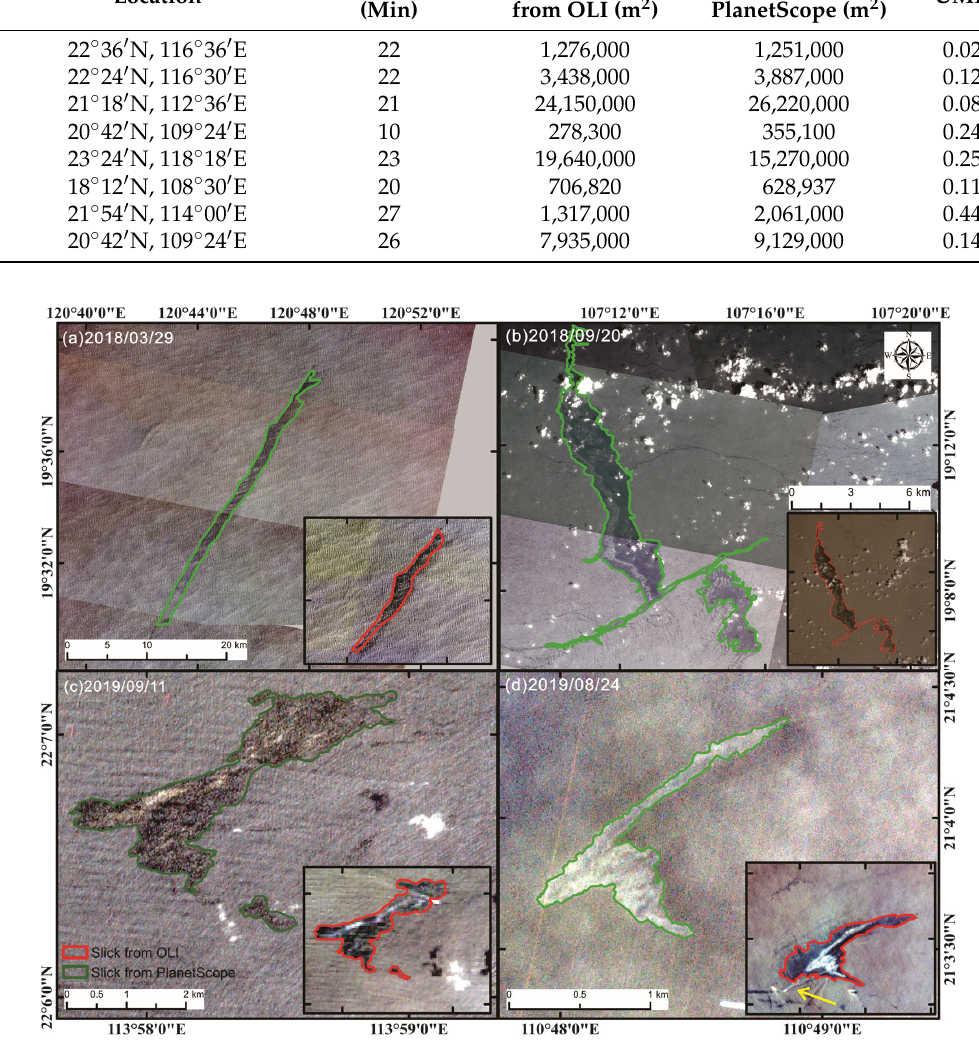
Figure 12. Same day image pairs from PlanetScope and OLI (insets), with a time difference of: ( a ) 26 min; ( b ) 13 min; ( c ) 13 min; and ( d ) 18 min, respectively. The yellow arrow from the panel d inset is pointed to moving ship directly connected to the slicks, which was determined to be not released from the pointed ship. Table 4. Comparison of oil slick delineated results from the two sensors.